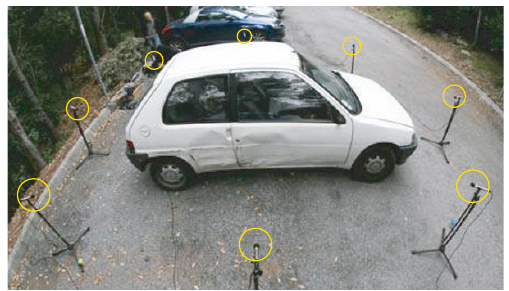
Figure 12: We capture an auditory environment featuring a com- plex sound source (car engine/exhaust, passengers talking, door slams, and onboard stereo system) using 8 microphones surround- ing the action.